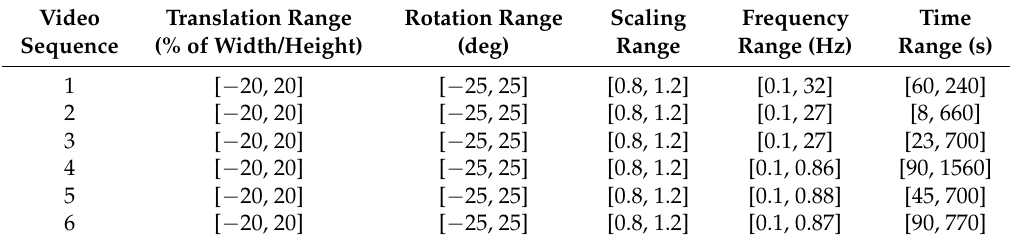
Table 2. Input parameter ranges considered for sensitivity analysis. Time ranges were set as wide as possible, provided that fire was present in the scene. Maximum sampling frequency corresponds to video recording